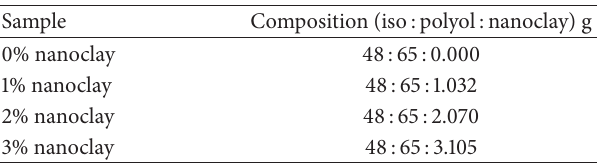
Table 1: Sample composition.